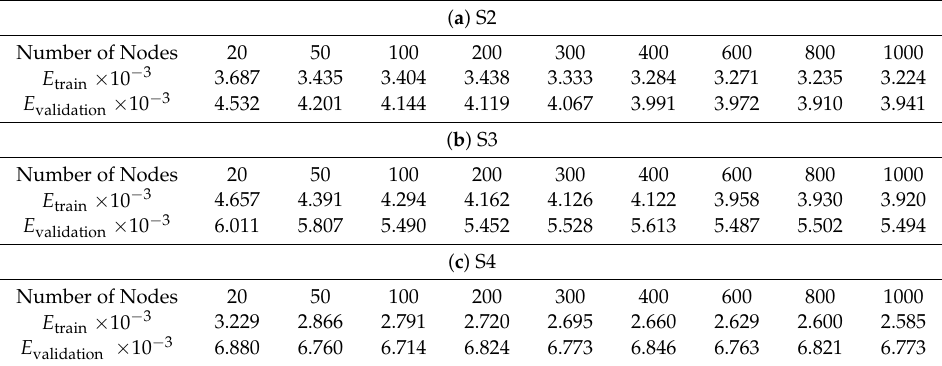
Table 1. Effects of different numbers of hidden layer nodes on model performance.